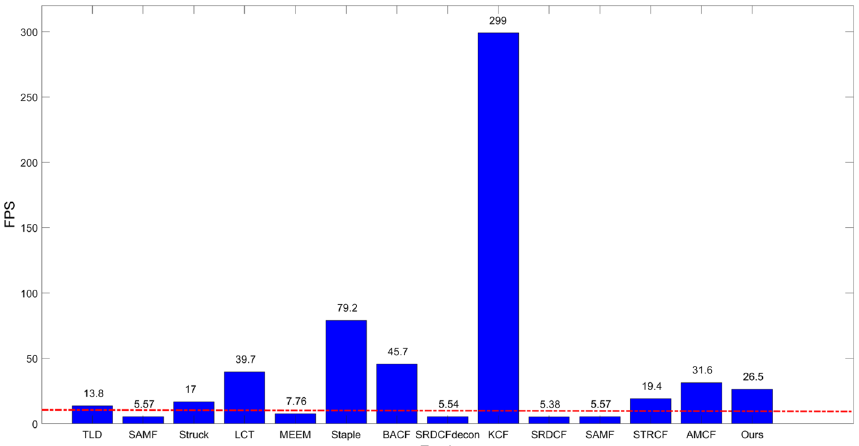
Fig. 13 FPS comparison results of all trackers on 123 UAV sequences. The red dashed line represents the capturing speed of the original UAV